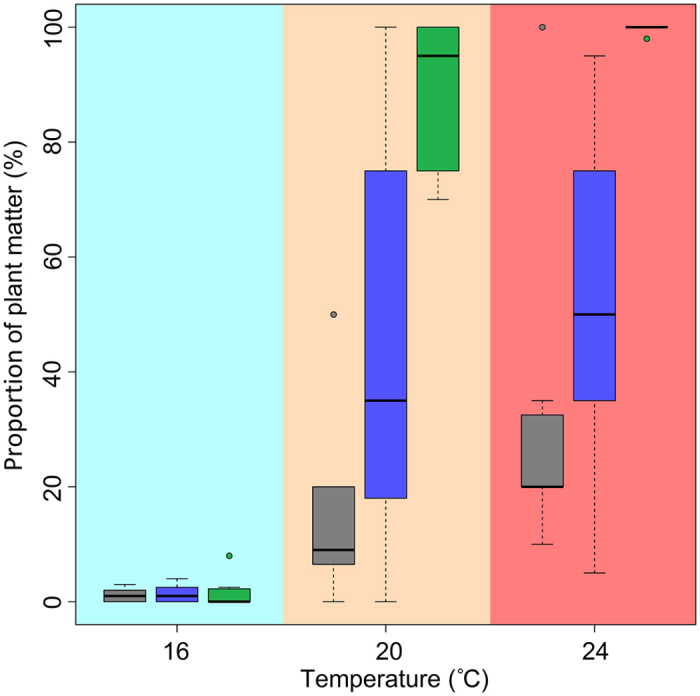
Proportion of plant matter in gut content of experimental rudd in given temperatures and three different diet ratios.The diet ratios of animal prey vs. plant matter were 1:1 (grey), 1:10 (blue) and 1:400 (green). Box and whiskers plots: upper and lower quartiles (boxes), median values (line inside the boxes), maximum and minimum values (whiskers), and outliers (circles) are shown.